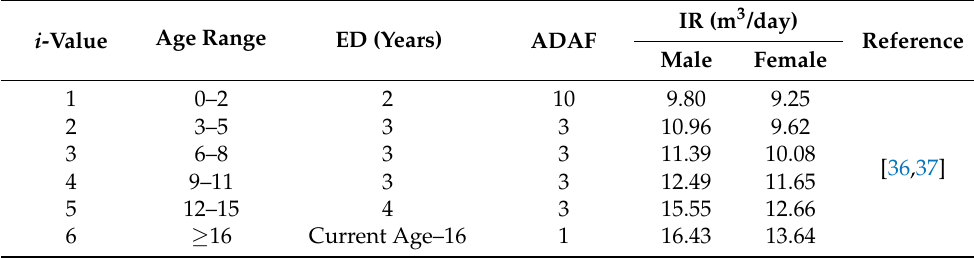
Table 4. The concentration of the selected toxic compounds in cigarette smoke composition and their inhalation toxicity